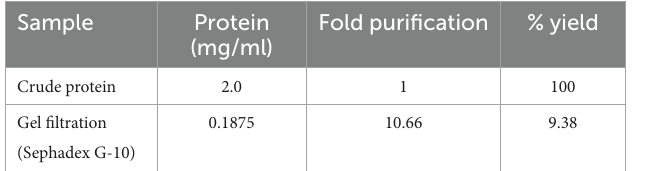
TABLE 2 Purification chart of Glutamicibacter mysorens intracellular protein.